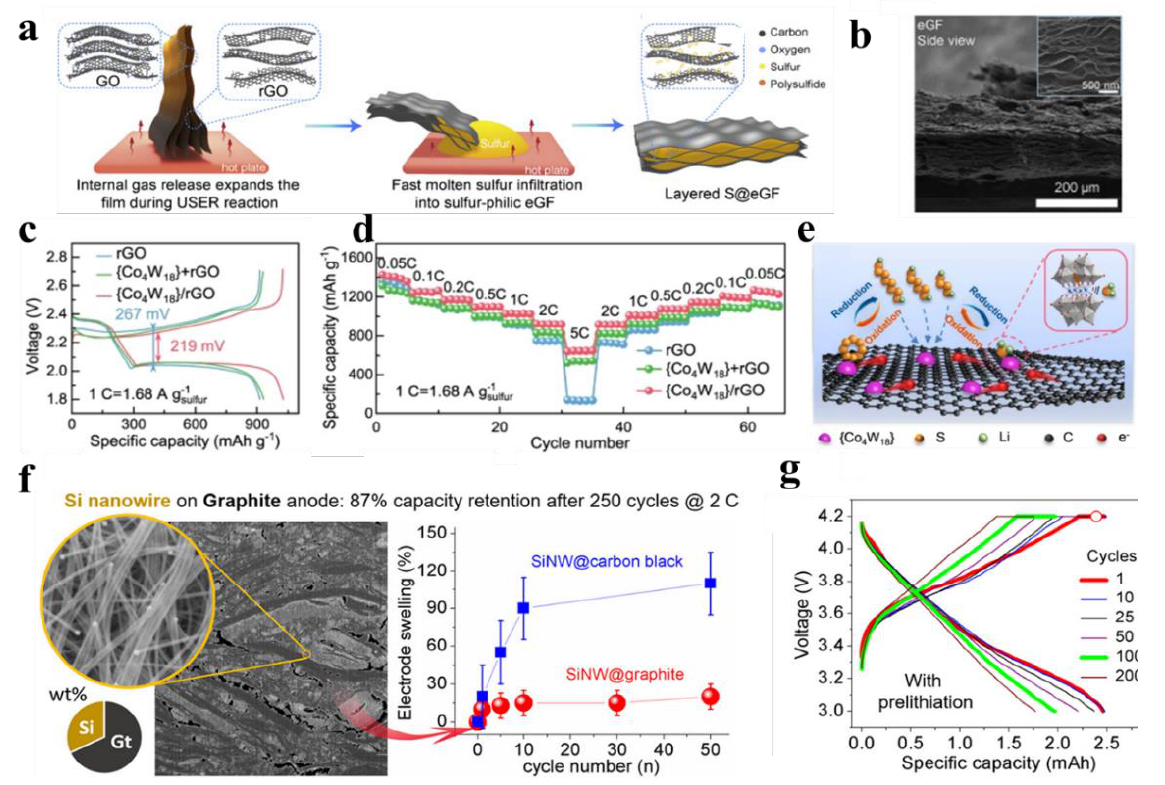
Figure 5. ( a ) Schematic diagrams; ( b ) SEM images for the expanded rGO film. Reprinted with permission from Ref. [48]. Copyright 2020 American Association for the Matter.; ( c ) Galvanostatic discharge–charge curves at 1 C (i.e., 1.68 A gs − 1); ( d ) Rate performance of various sulfur cathodes at different specific current; ( e ) Schematic illustration of bifunctional catalytic effect for Li2S deposition and oxidation on the surface of Co4W18/rGO composites. Reprinted with permission from Ref. [49]. Copyright 2022 American Association for the Nature Communication; ( f ) Characterization of Gt − SiNW and Thickness and swelling percentage of electrodes vs. cycle number for SiNW@carbon black and SiNW@graphite; ( g ) prelithiation at C/2 rate. Comparison of corresponding reversible ca- pacities, and Coulombic efficiency. Reprinted with permission from Ref. [75]. Copyright 2020 Amer- ican Association for the ACS Nano.